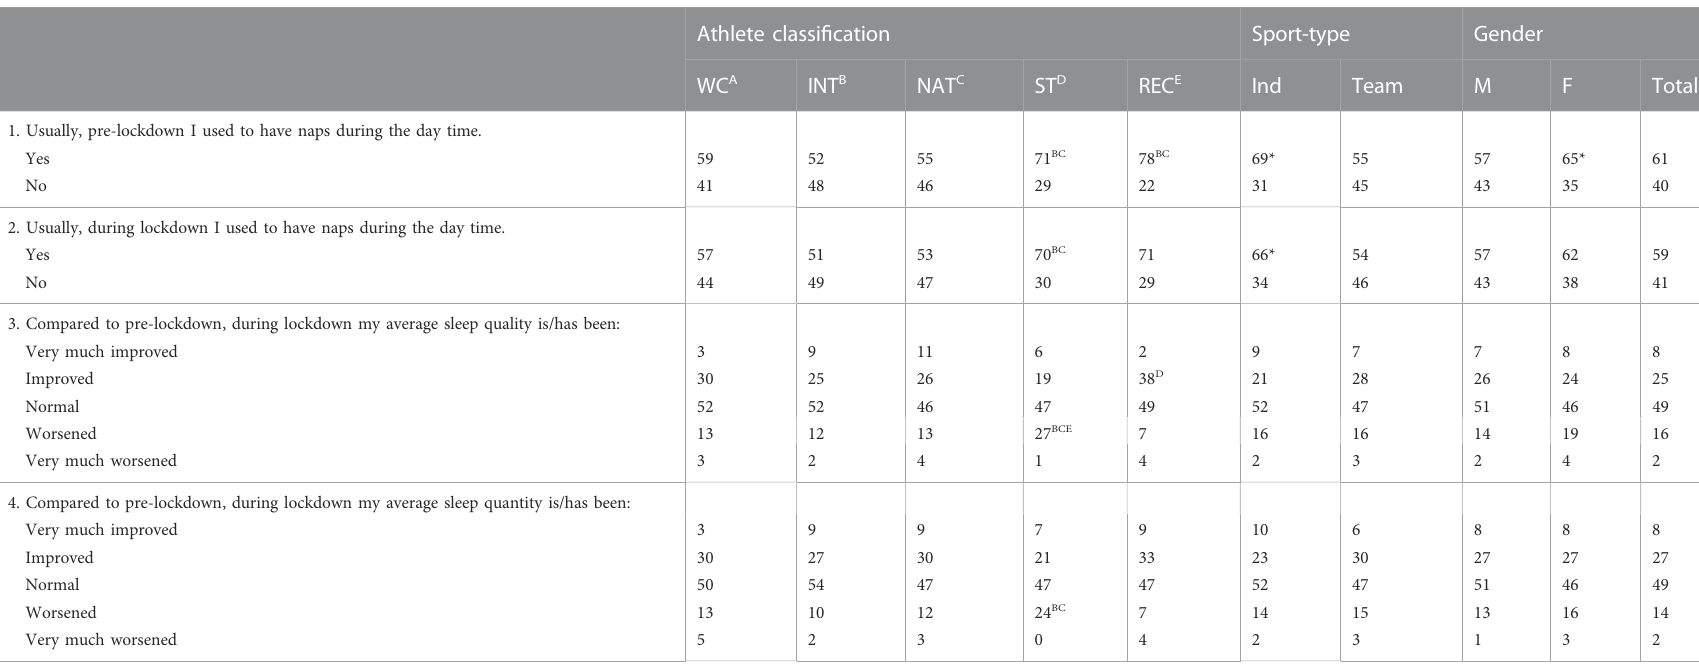
TABLE 5 Sleep pattern during lockdown in Malaysia based on athlete classi fi cation, sport-type, gender, and total cohort (percentage of